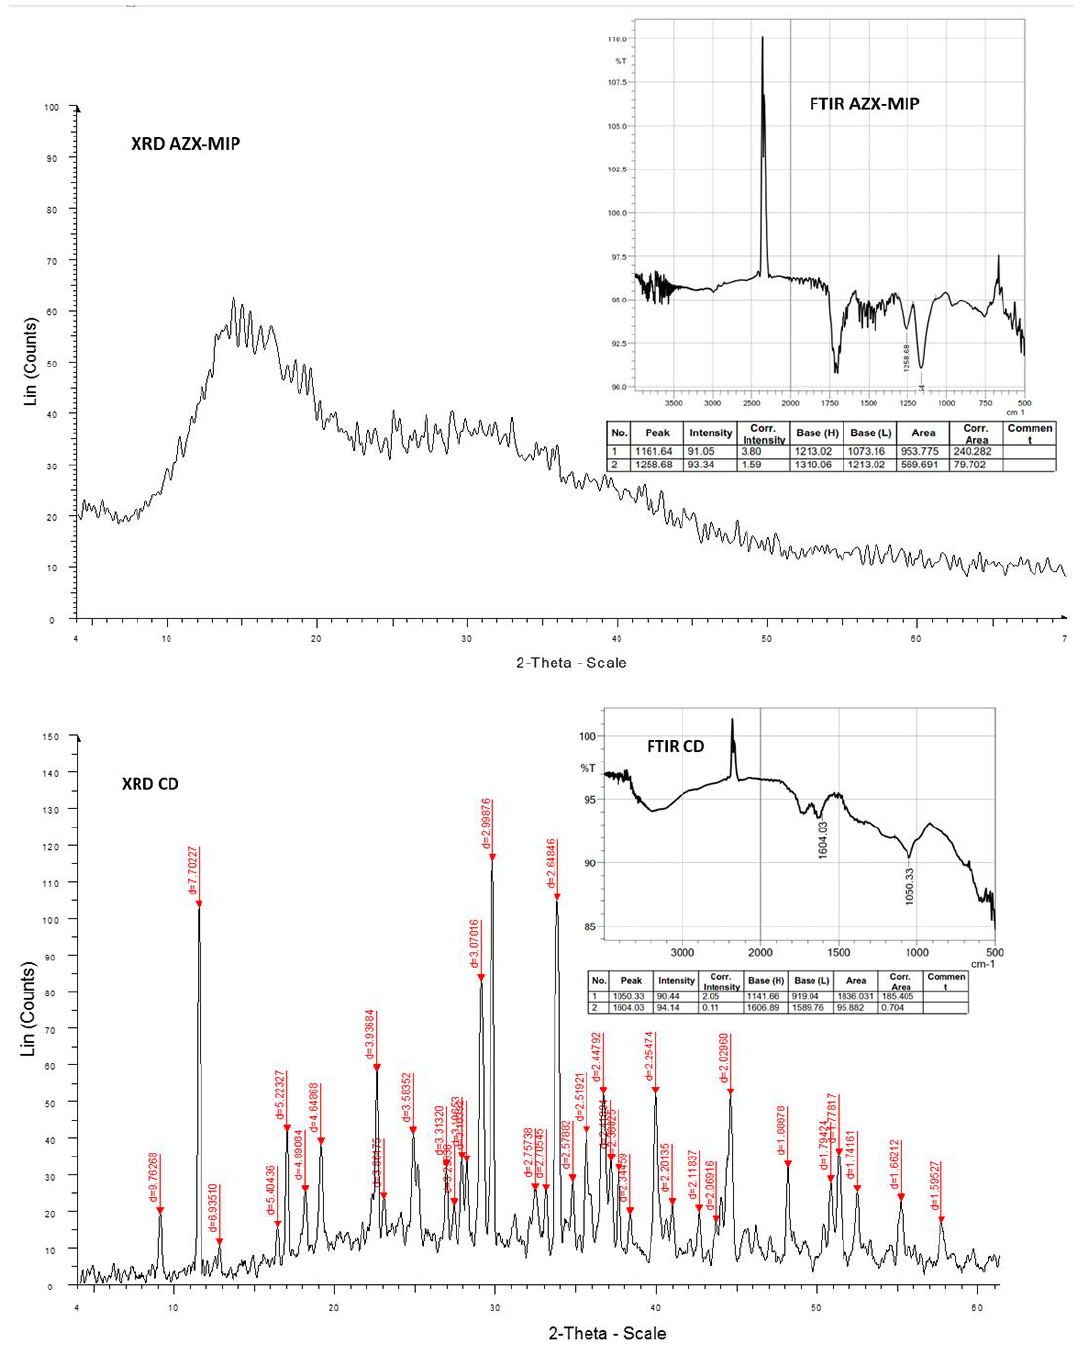
Fig. 3. X-ray diffraction patterns and FTIR charts of MIP and